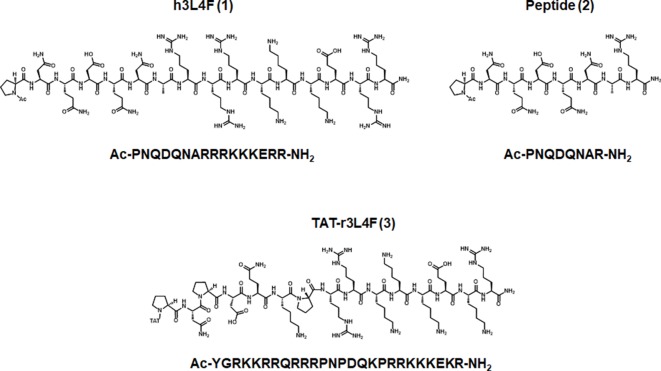
Parent peptides h3L4F (1), 2, and TAT-r3L4F (3), modified from Anastasio et al., 2013.